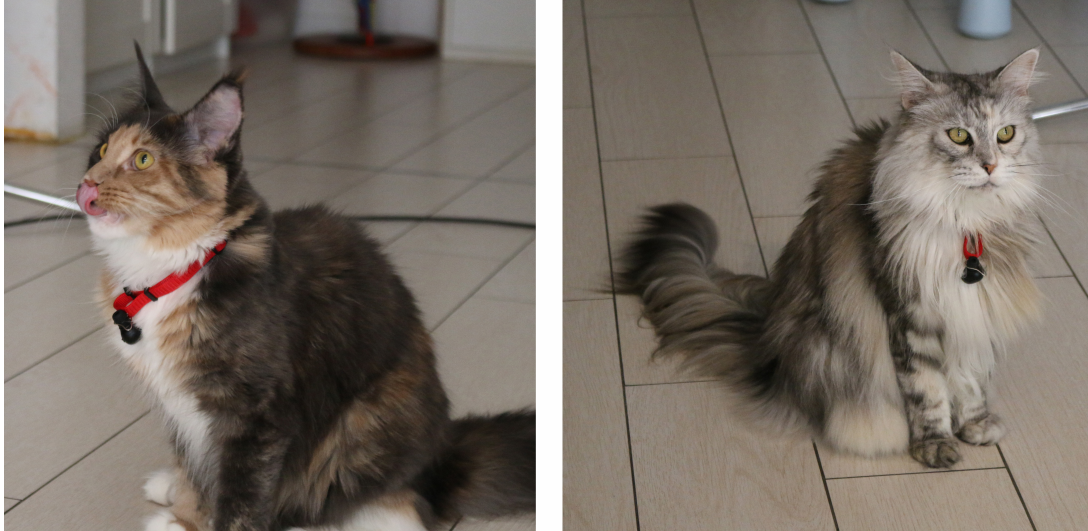
Figure 3. Two cats provided with a Bluetooth microphone placed on the collar and pointing